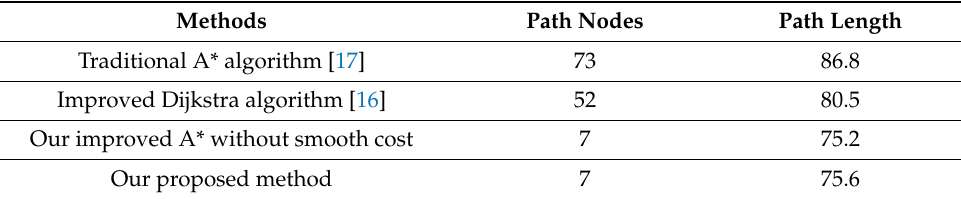
Table 1. The comparison between our proposed path planning and different methods.